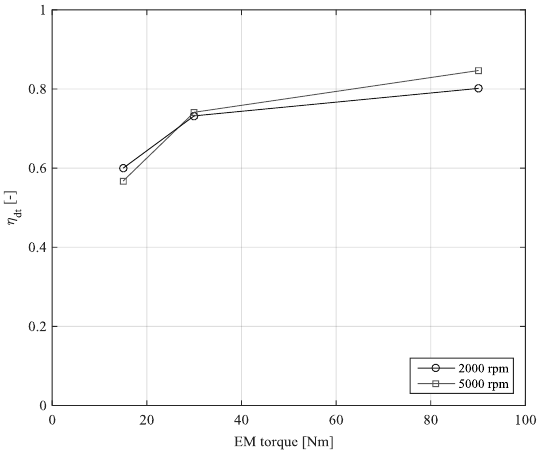
Figure 10. Comparison of the experimentally measured efficiencies of the case study DCT and HAMT at 𝜔 𝑖𝑛 = 2000 rpm and 𝜃 𝑡𝑟 = 70 °C: ( a ) first gear; ( b ) seventh gear (DCT) and sixth gear (HAMT).